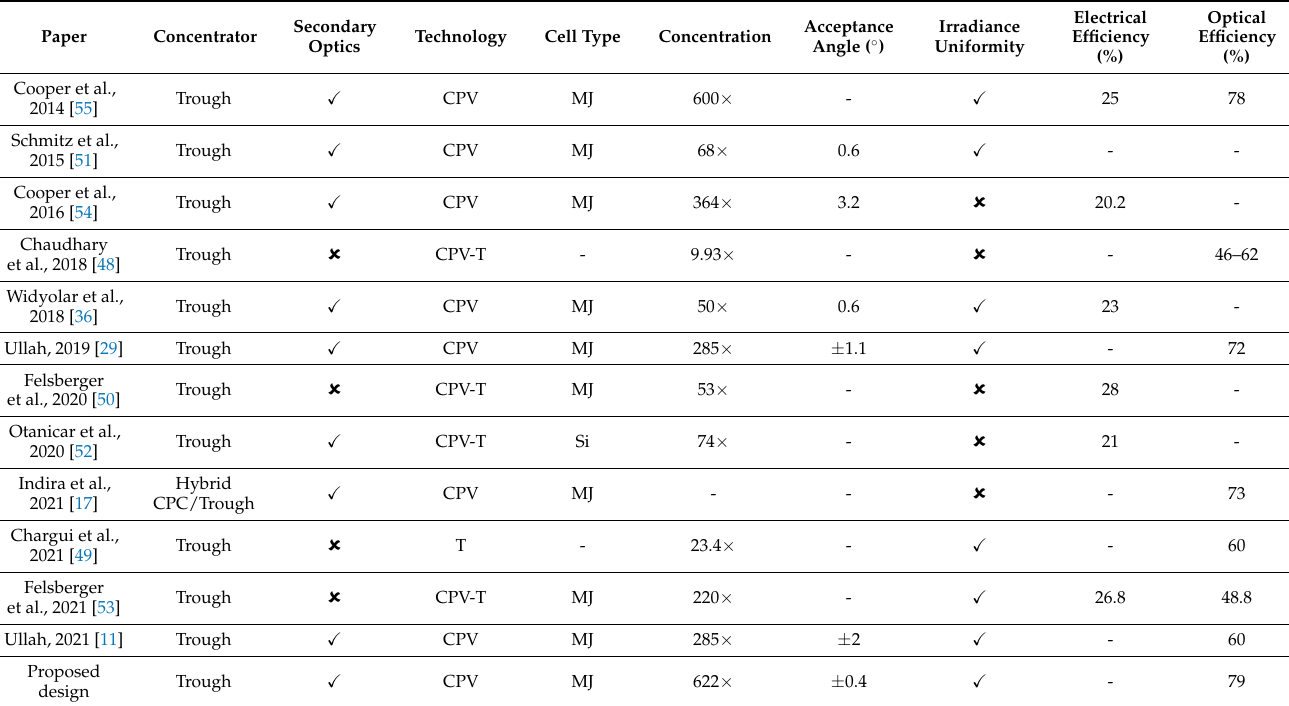
Table 2. Comparison of the parabolic trough-based concentrating systems.